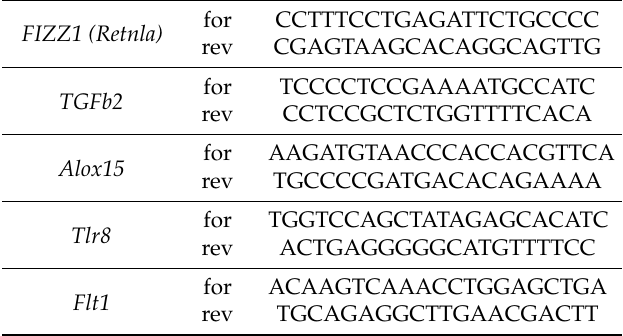
Figure 2. Gene expression analysis in monocytes and Kupffer. Heatmaps depict relative expression levels of inflammation-related genes ( A ). Gene expression profiles (PCR-RT) for MNCs and KCs ( B ). The data are presented as means with the bars for standard deviations. The data are listed as mean ± standard deviation. * p < 0.05 monocytes vs Kupffer cells. KCs: Kupffer cells; MNCs: monocytes. Table 2. Primers for polymerase chain reaction